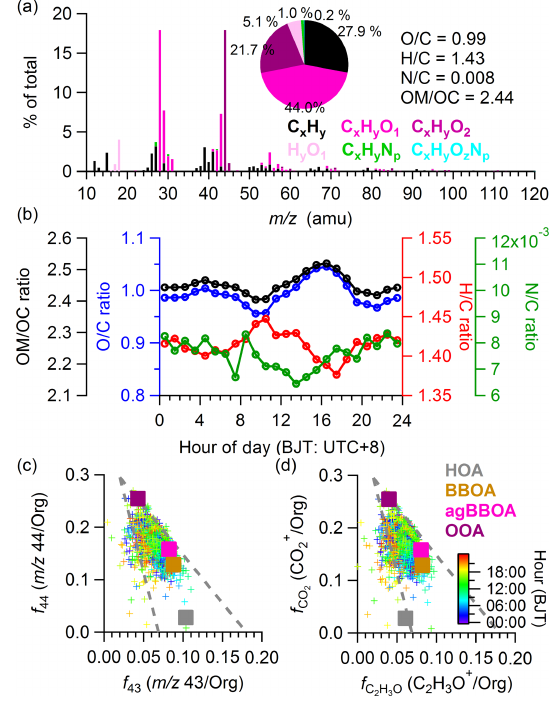
Figure 4. (a) The average high-resolution mass spectrum of organ- ics colored with six ion categories (pie chart shows the average con- tributions of the six ion categories); (b) diurnal variations of element ratios (O / C, H / C, N / C and OM / OC); and scatterplots of (c) f 44 vs. f 43 and (d) f CO + vs. f C 2 H 3 O + colored by time of the day, 2 where the corresponding values of four organic components are also